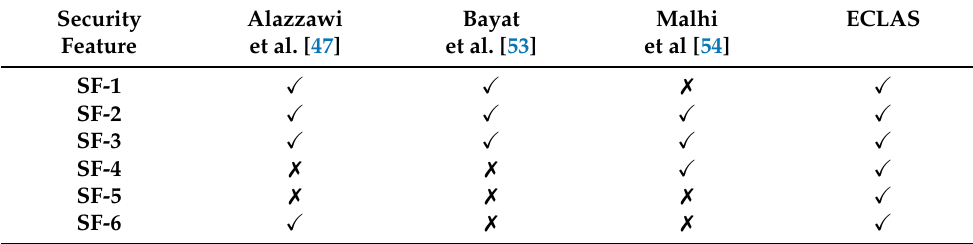
Table 2. Comparison Analysis of Security Features